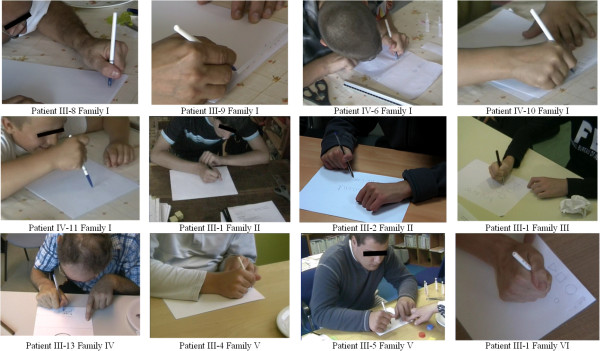
Pen holding in
ARX
patients.